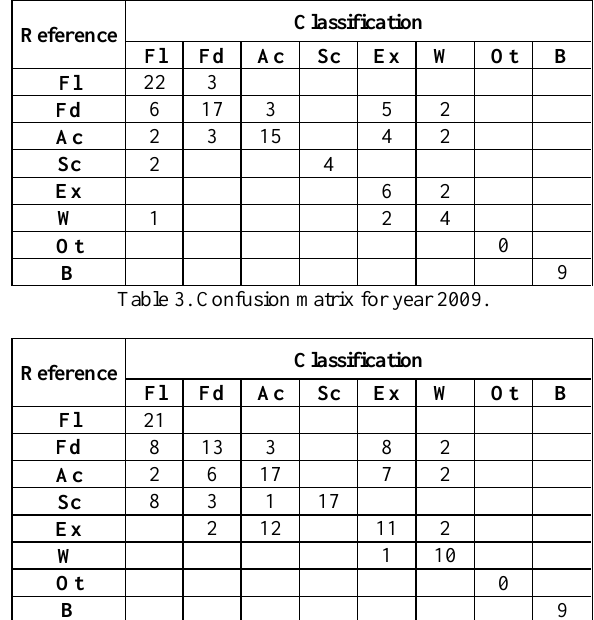
Table 4. Confusion matrix for year 2019.